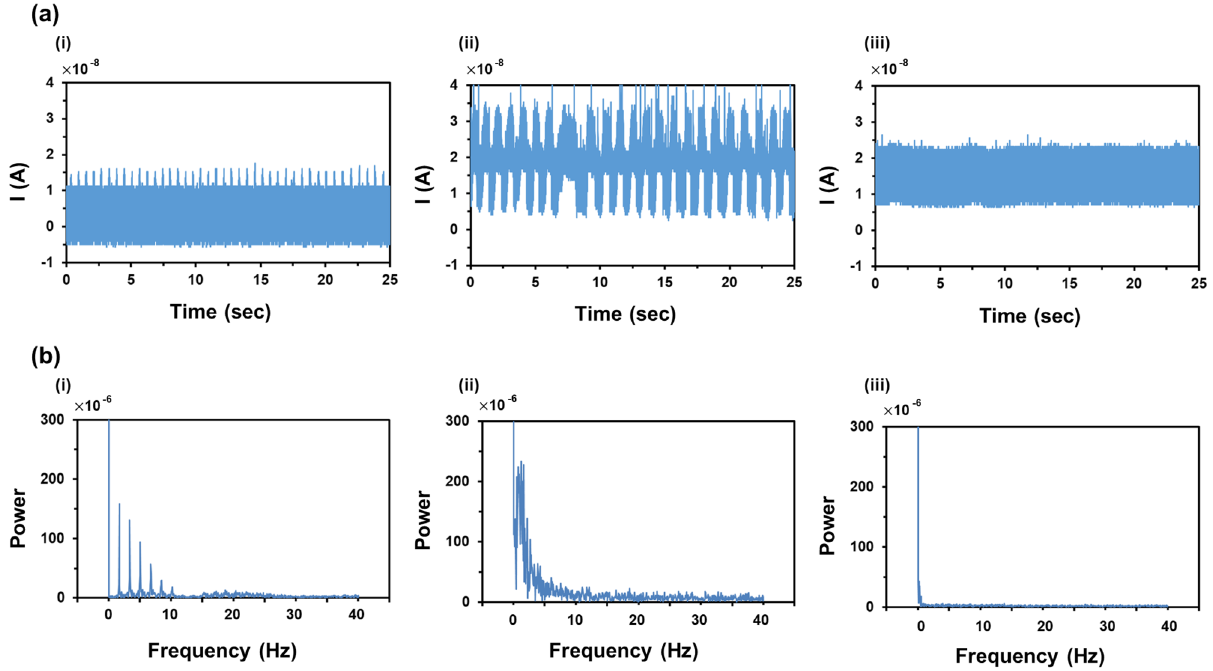
Figure 6. Measured signals of ( a ) current data and ( b ) frequency data. ( i ) dripping, ( ii ) pulsating, and ( iii ) cone-jet.